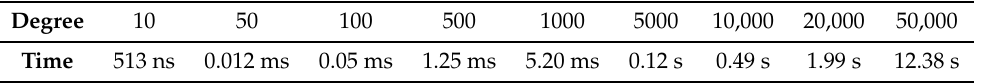
Table 1. Running time used to build the polynomial with Lagrange